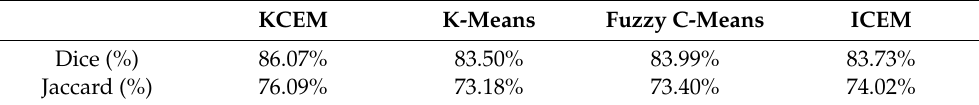
Table 8. Non-mass tumor: Dice similarity coefficient and Jaccard similarity coefficient of each method.